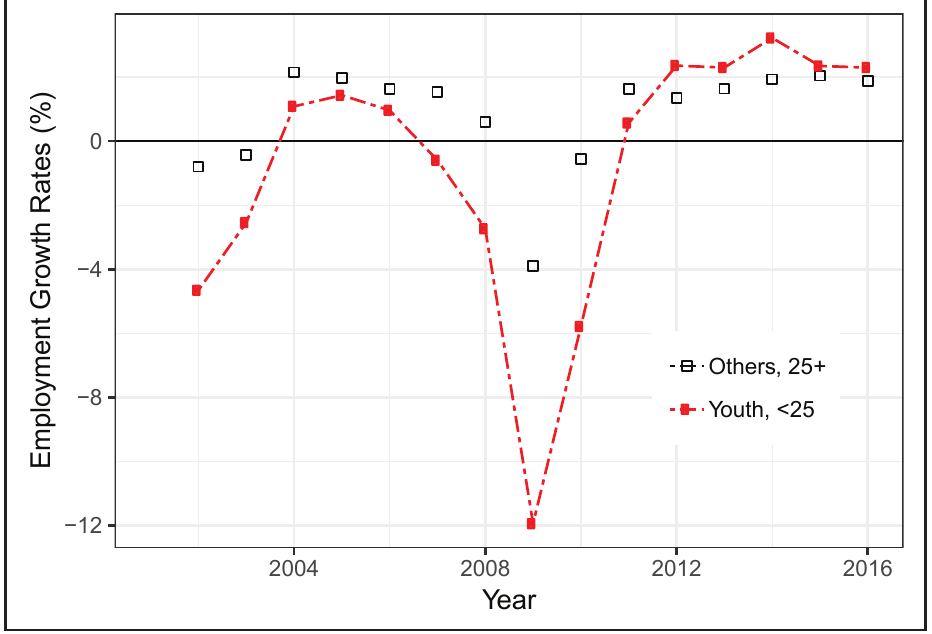
Figure 1 Employment growth rates for US youth: 2002–2016. The graph plots year-on-year employment growth for persons aged 14–24 years as linked circles on the vertical axis, and for the rest of the US population as squares. (Data from the U.S. Census Quarterly Workforce Indicators Database [QWI]). The following states were excluded because of incomplete data between 2001 and 2016: Arizona, Arkansas, District of Columbia, Massachusetts, and New